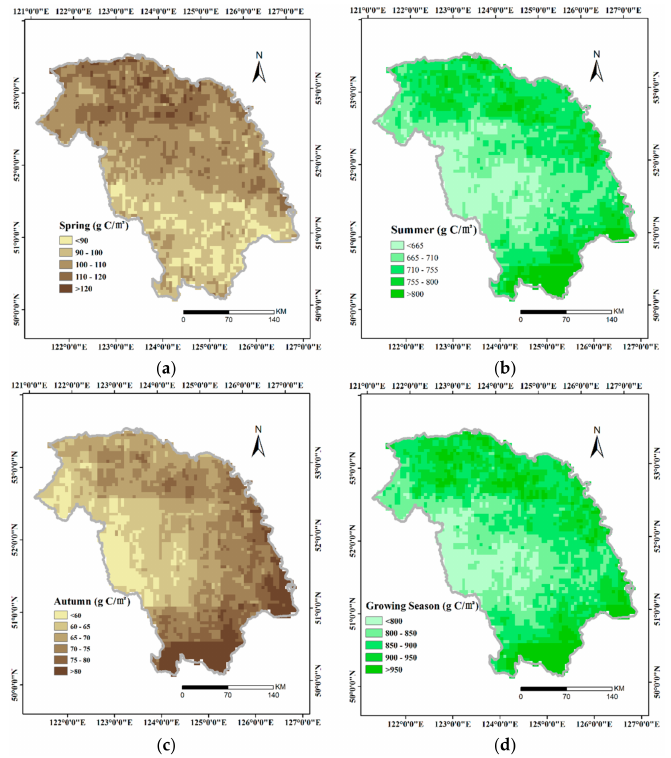
Figure 2. Spatial distribution of ( a ) spring-average accumulated gross primary productivity (AG); ( b ) summer-average AG; ( c ) autumn-average AG; and, ( d ) growing season (GS)-average AG during